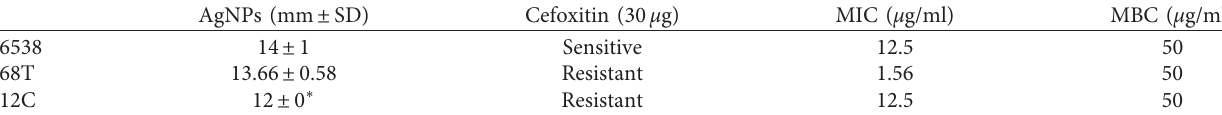
Figure 4: Percentages of viability of B16 melanoma cell lines treated with various concentrations of AgNPs after 24h of exposure and evaluated by MTT reduction assay. Error bars represent standard deviations. ∗ Differences were considered significant at p < 0 . 05. Table 2: Antibacterial activity of biosynthesized AgNPs against methicillin-resistant S. aureus strains.